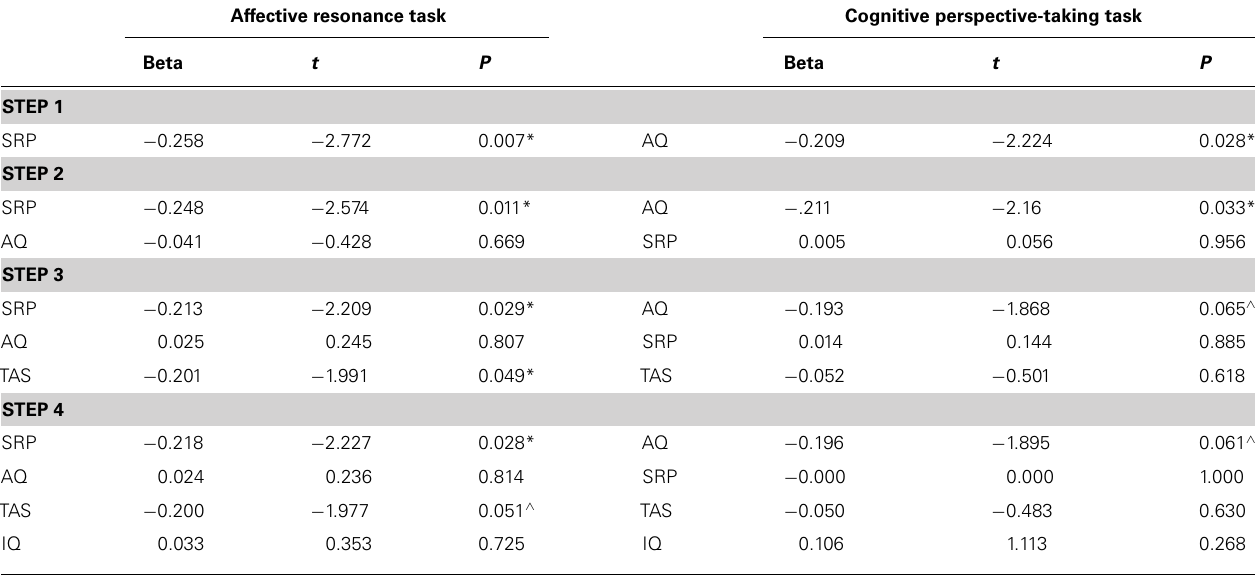
Table 2 | Hierarchical multiple regression between questionnaire measures of psychopathic, autism spectrum disorder, and alexithymic traits and task performance. Affective resonance task Cognitive perspective-taking